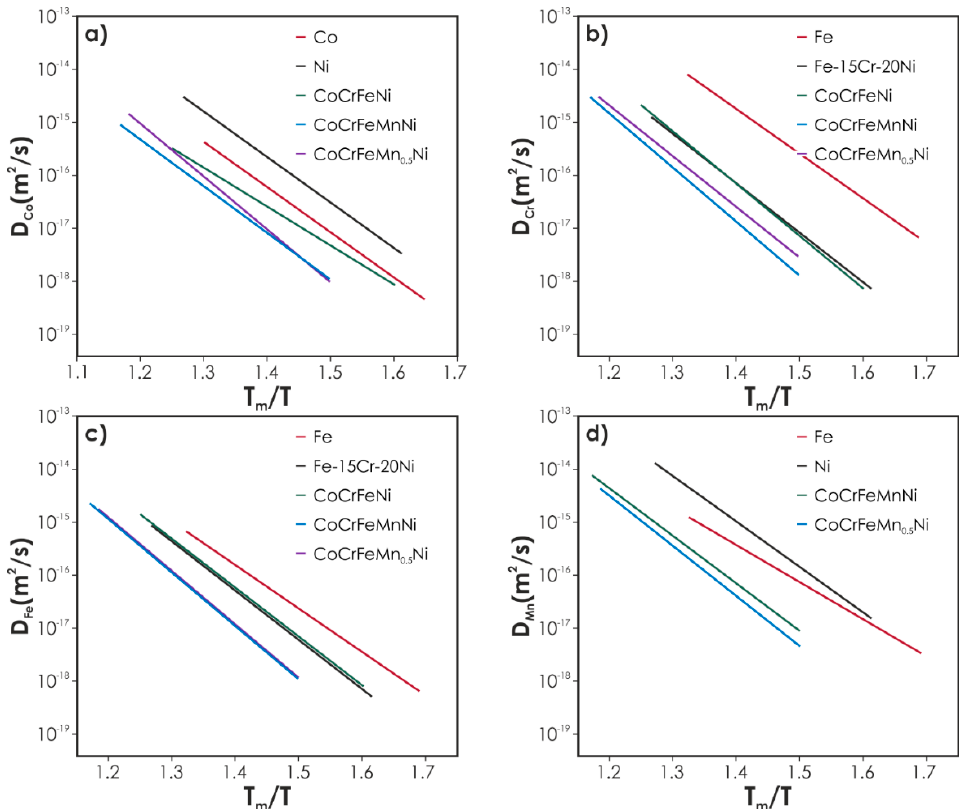
Figure 19. Tracer diffusion coefficients in high entropy alloys (HEAs) [28,39] in comparison to other FCC-structured alloys and pure elements: ( a ) Co; ( b ) Cr; ( c ) Fe; ( d ) Mn (after [39]). Reprinted from Acta Materialia 146 (2018), Bulk tracer diffusion in CoCrFeNi and CoCrFeMnNi high entropy alloys, 211–224, Copyright 2018, with permission from Elsevier.